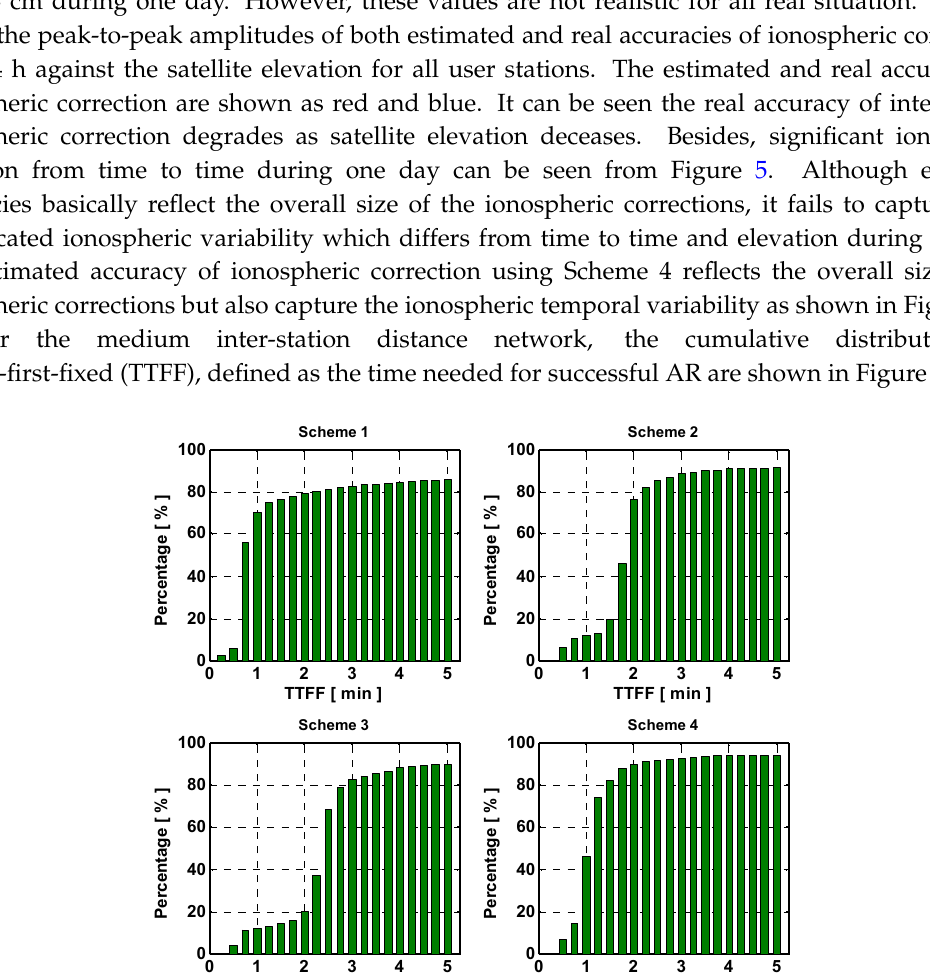
Figure 5. Interpolated slant ionospheric accuracy at user station P502.